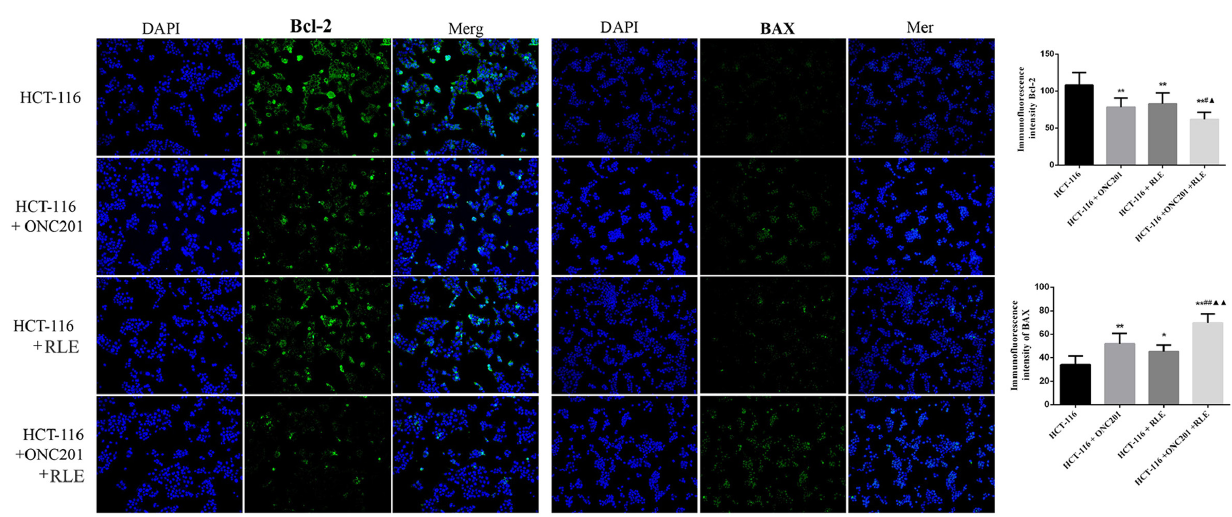
Figure 6. Immunofluorescence assays for assessing the effects of RLE and ONC201 co-treatment on Bcl-2 and Bax expression in HCT116 cells. Magnification × 200. * P < .05, ** P < .01 vs. the HCT116 group; # P < .05, ## P < .01 vs. the HCT116 + ONC201 group; ▲ P < .05, ▲▲ P < .01 vs. the HCT116 + RLE group. RLE, raw lacquer